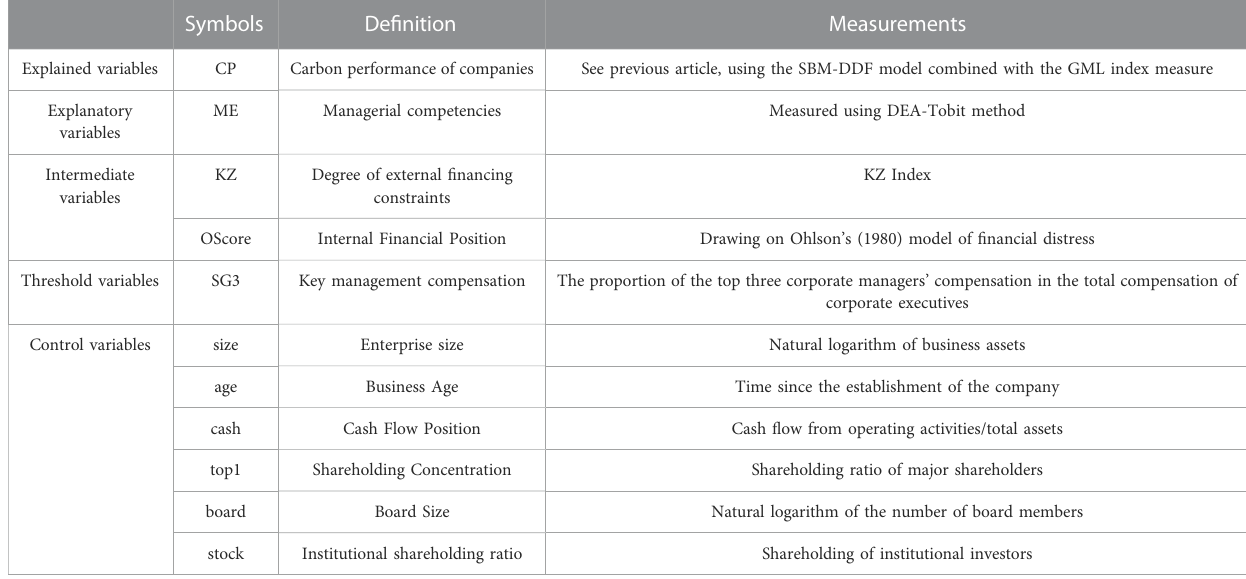
TABLE 1 Variable de fi nitions.